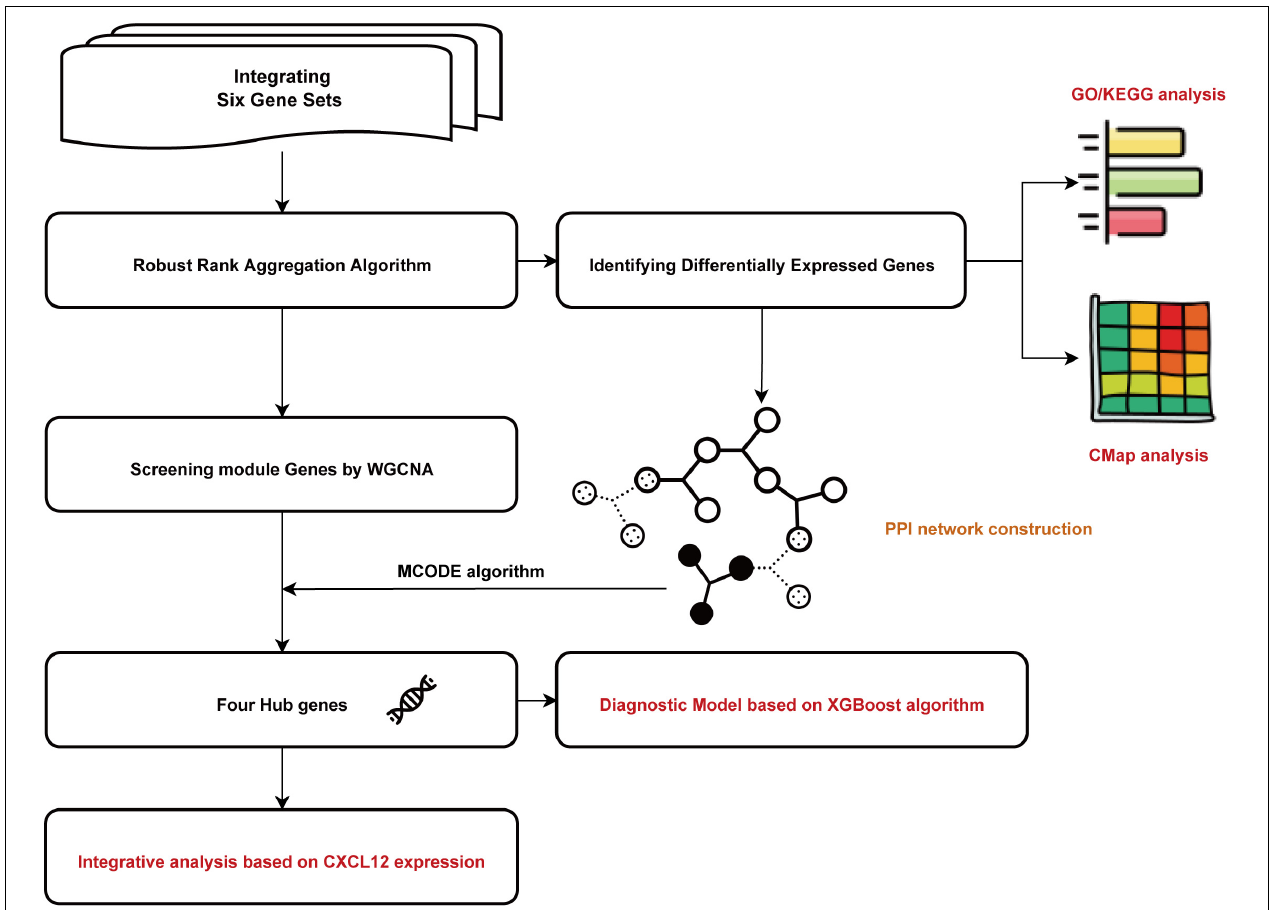
FIGURE 1 | Flowchart of the bioinformatics analysis. GO, Gene Ontology; KEGG, Kyoto Encyclopedia of Genes and Genomes; WGCNA, the weighted gene coexpression network analysis; MCODE, Molecular Complex Detection; CMap, Connectivity Map. XGBoost, the eXtreme Gradient